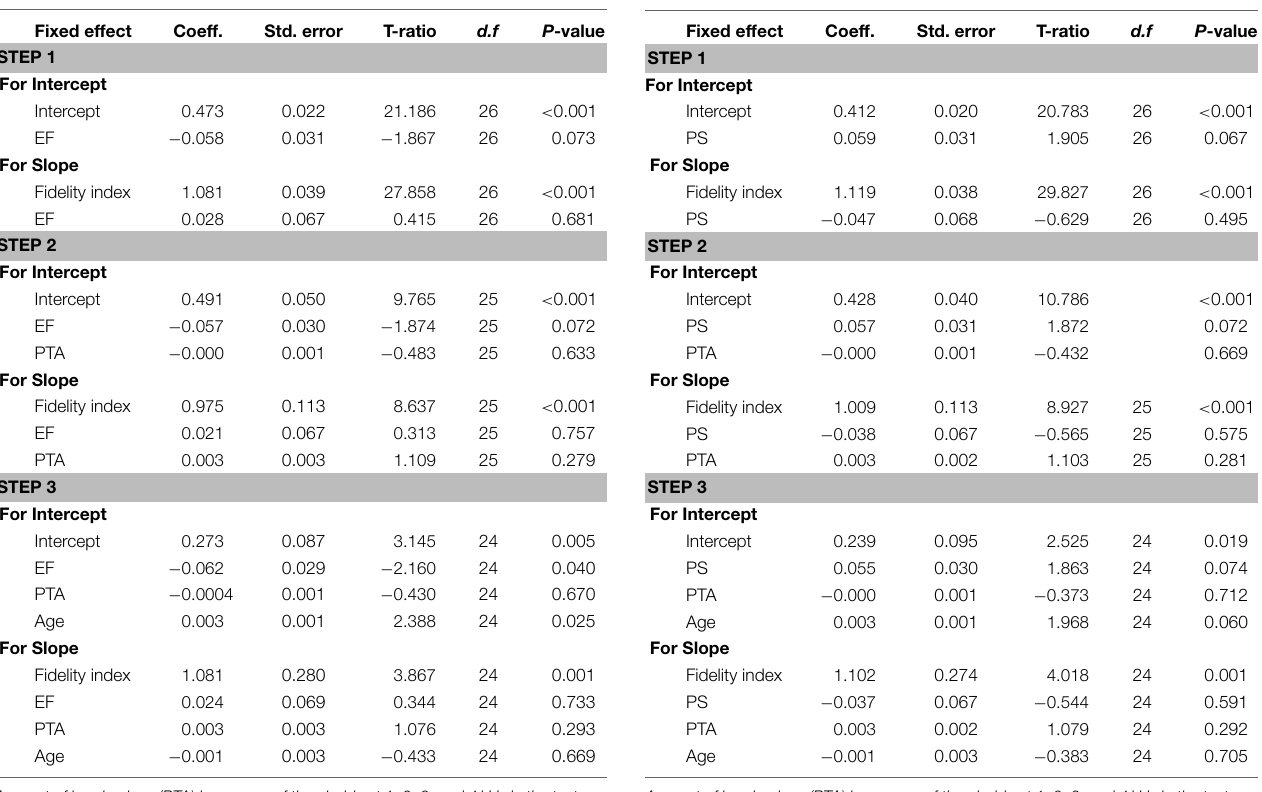
TABLE 7 | Summary of hierarchical linear model for quality with processing speed (PS) as a